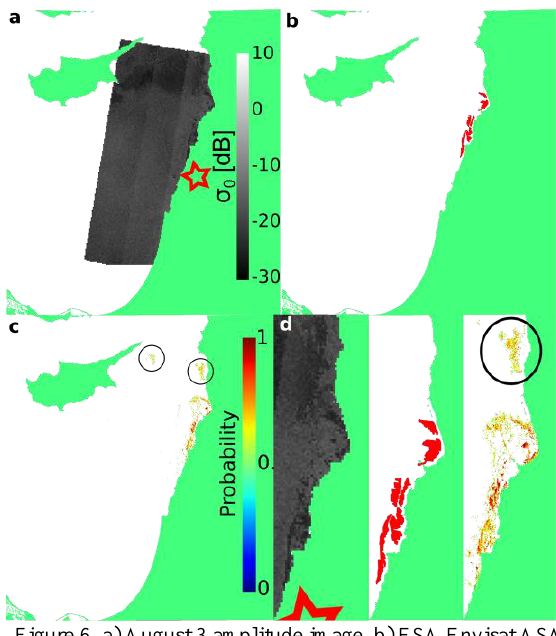
Figure 6. a) August 3 amplitude image. b) ESA Envisat ASAR and Modis August 3-4 spill map. c) Result with proposed algorithm. d) Zoom-in of the oil slick. Circles